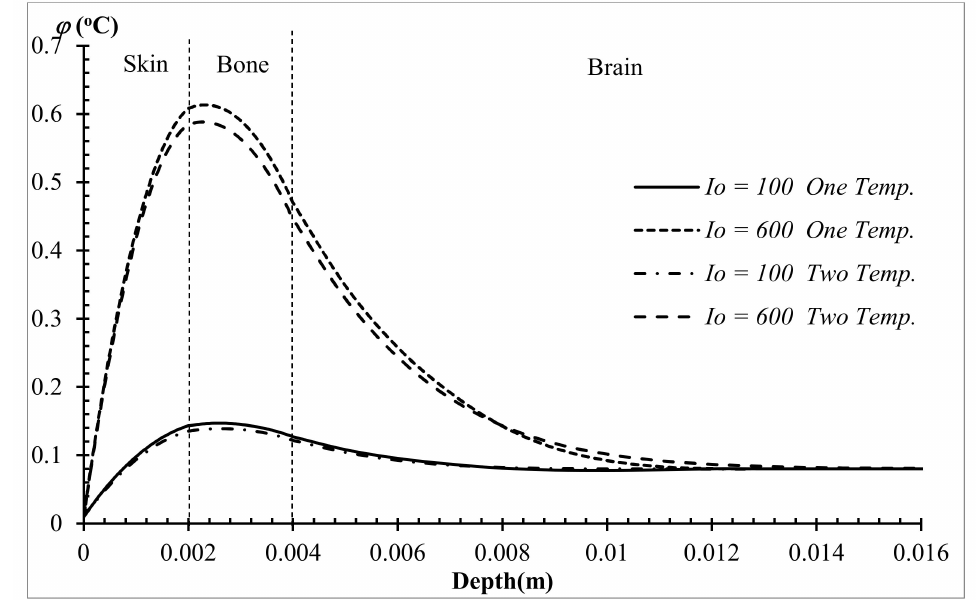
Figure 7. The conductive temperature increment with various power densities on a child’s